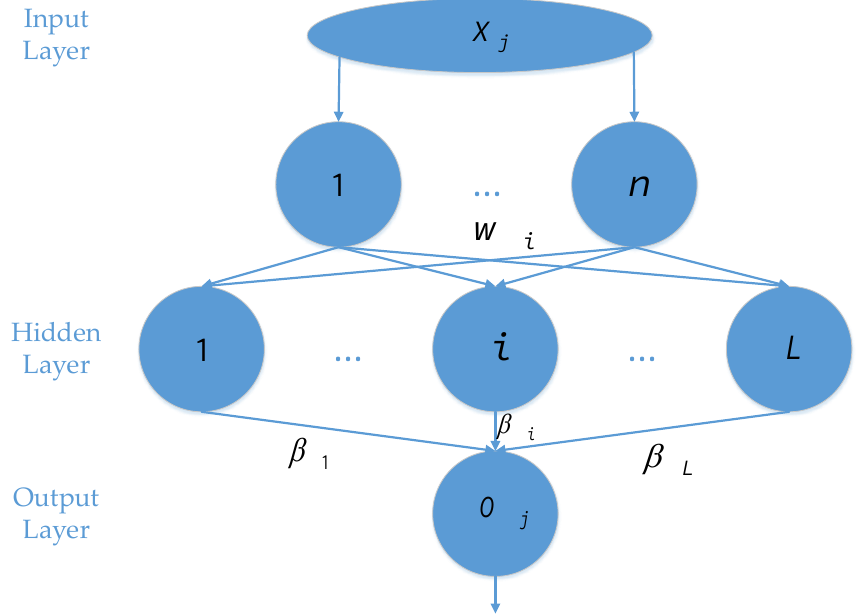
Figure3. ELM Algorithm Diagram. Figure 3. ELM Algorithm